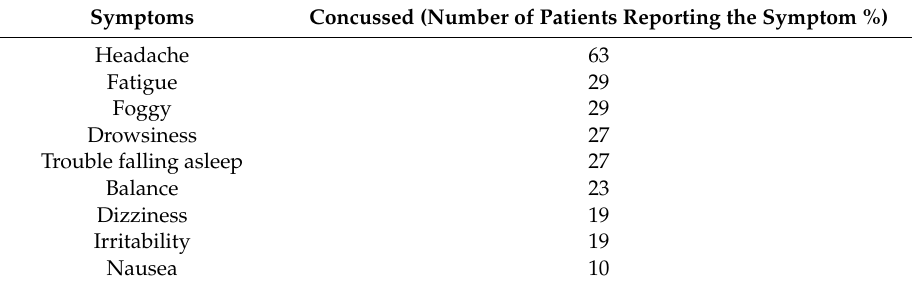
Table 1. The table represents the most common symptoms reported by patients following concussion in the study. Headaches were highly reported followed by fatigue, feeling foggy, drowsiness, and having trouble falling asleep. In a few cases nausea was also present. Data is presented as a percentage of total number of patients. Concussed = 51. Symptoms Concussed (Number of Patients Reporting the Symptom %) Figure 3. Outcomes of the Wechsler Adult Intelligence Scale (WAIS) symbol search and Impact test for concussion for the patients within this study. Following comprehensive clinical assessment of the WAIS symbol search and Impact test on healthy (H) and concussed (C) athletes it was found that the number of symbols entered ( A ), the impact on impulse control ( B ) and the impact symptom score ( C ) were significantly altered. Data is represented as the mean and individual data points were data was analyzed for significance using the unpaired T test where * p < 0.05, ** p < 0.01. WAIS symbol search n : H = 12, C = 15. Impact test n : H = 12 C = 15.